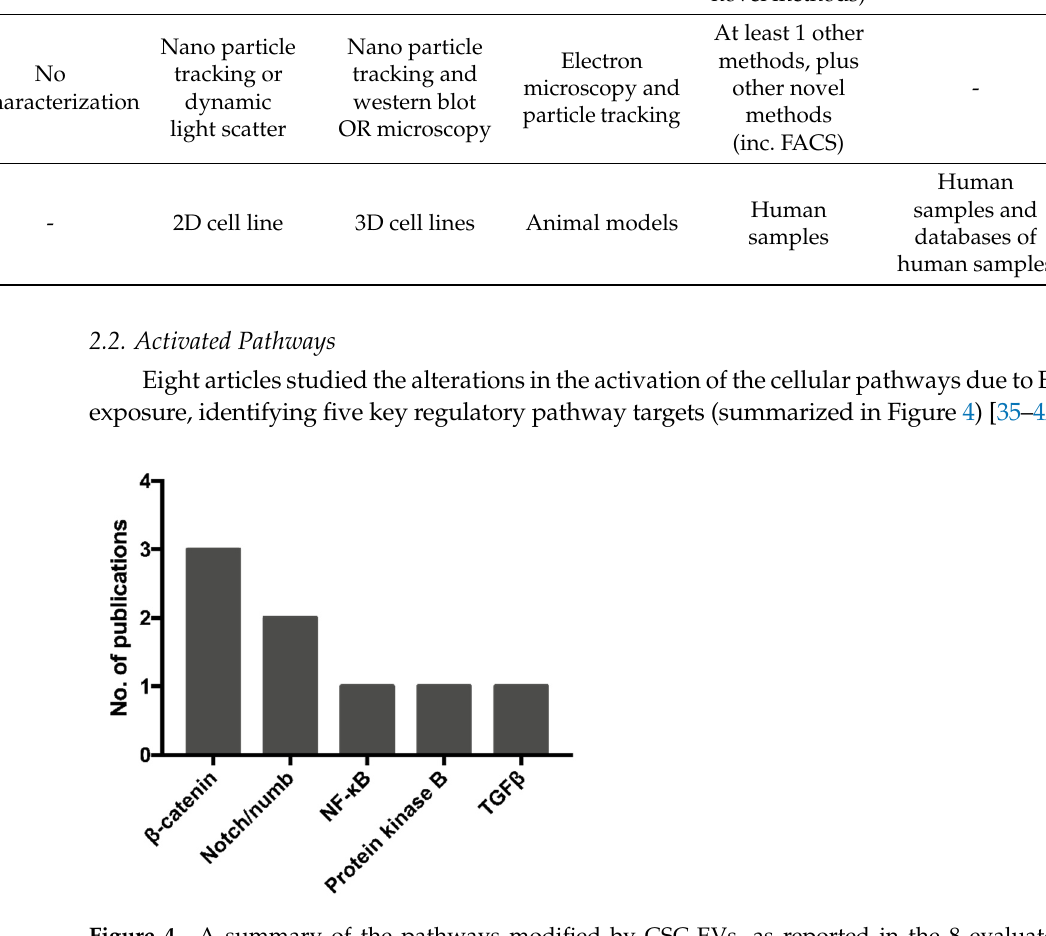
Figure 4. A summary of the pathways modified by CSC-EVs, as reported in the 8 evaluated studies (31–38). The Wnt/ β -catenin and Notch pathways featured in the majority (5/8) of the studies reviewed .